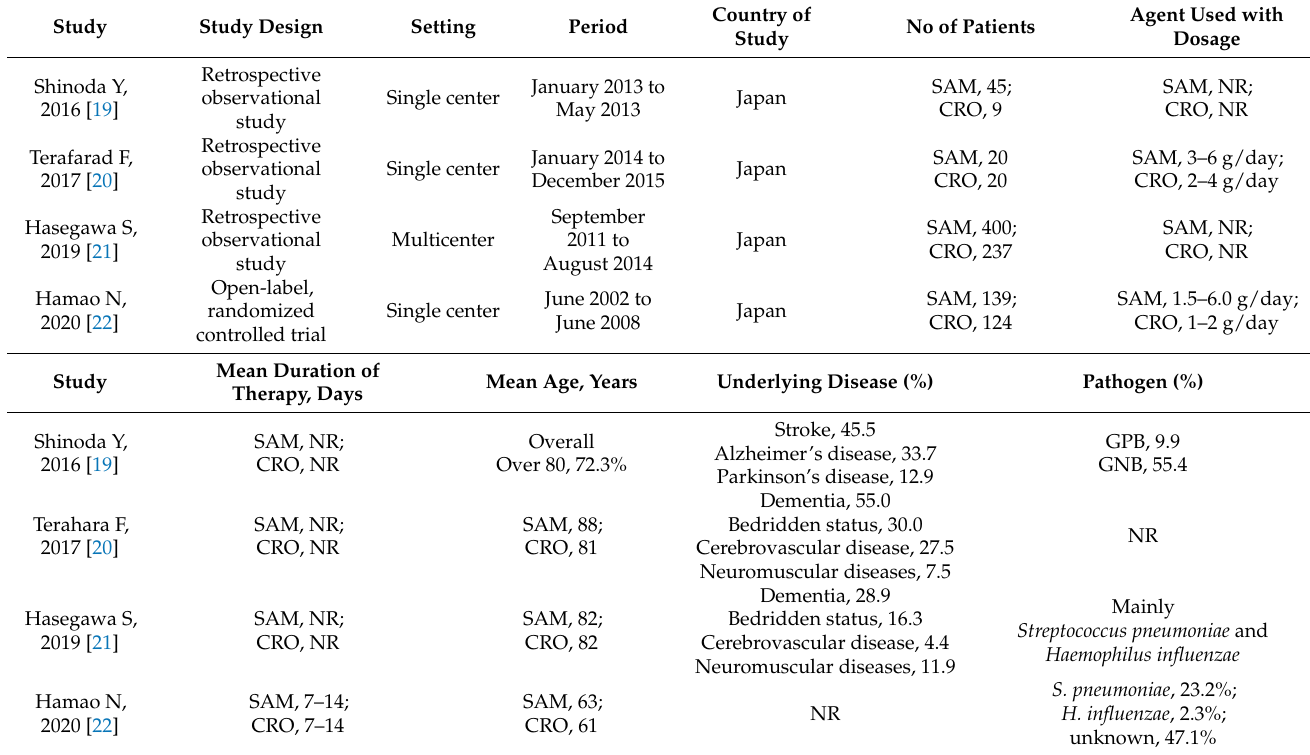
Table 1. Characteristics of the Studies Included in the Meta-Analysis.